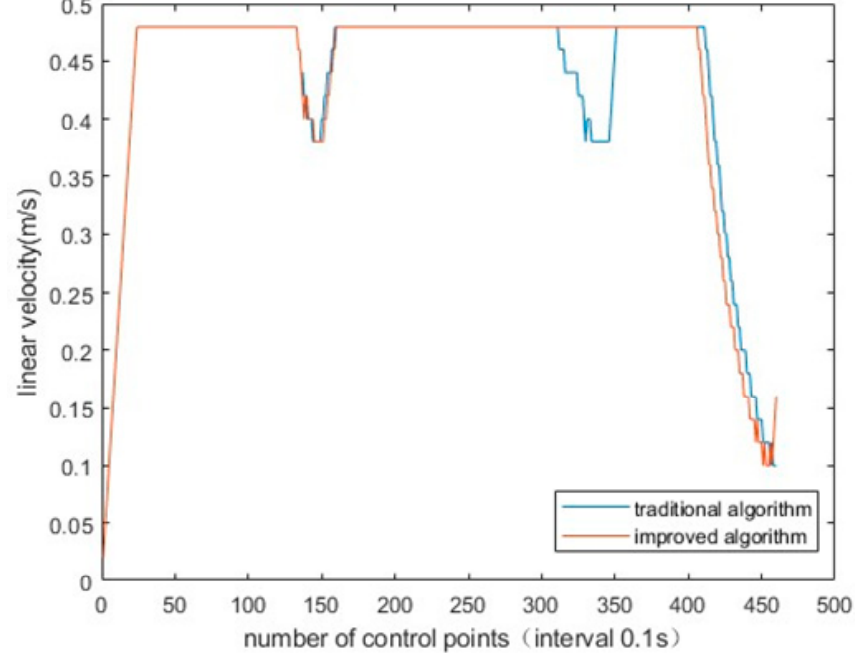
Figure 11. Improved algorithm and traditional algorithm for AGV linear velocity.